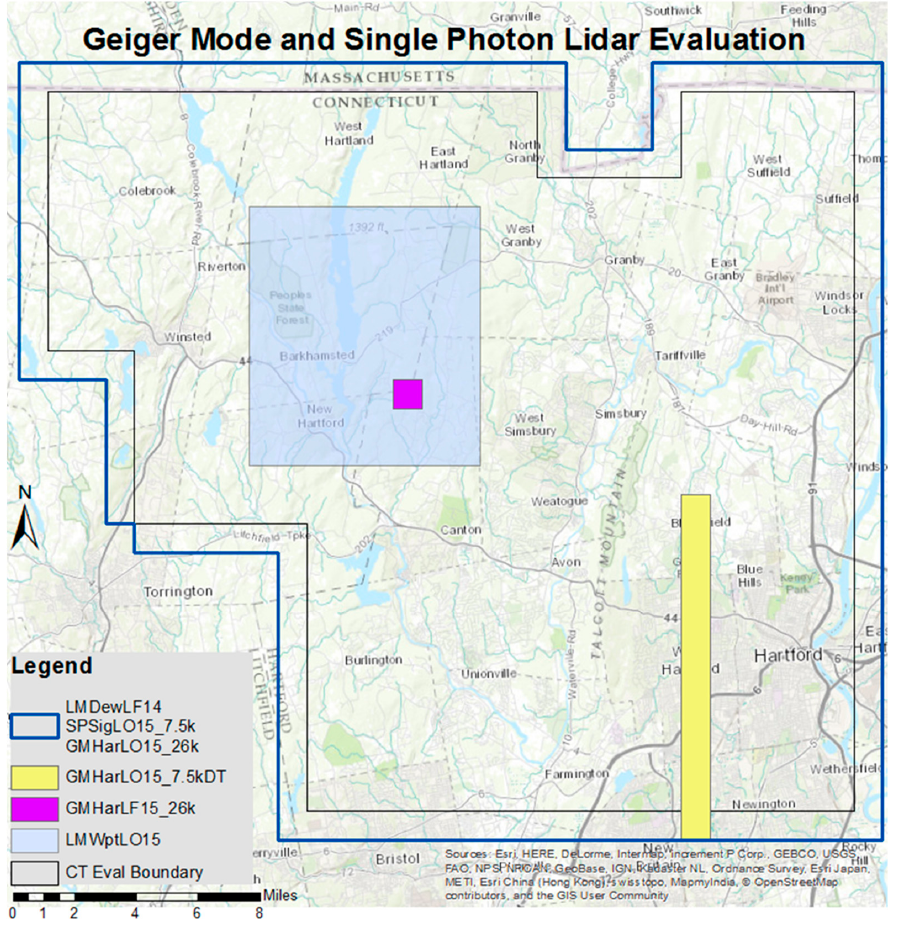
Figure 2. Location of leaf-on linear mode collection (LMWptLO15), IntelliEarth™ daytime collection (GMHarLO15_7.5kDT), and IntelliEarth™ sensor 2 leaf-off collection (GMHarLF15_26k). Table 2. List of datasets and their attributes that were used in this study.